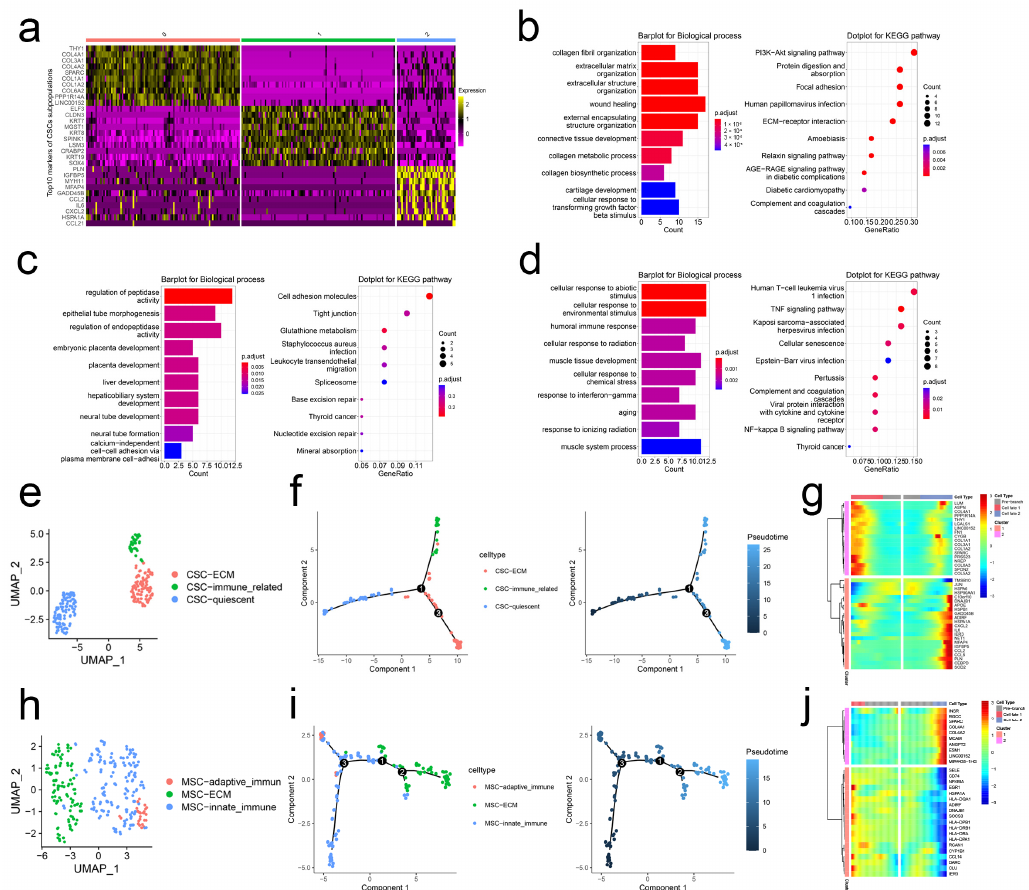
Figure 1. scRNA-seq analysis unravels the heterogeneity of CSCs and MSCs. ( a ) Top 10 markers of each subtype of CSCs. Top 10 terms of BP of GO and KEGG pathway enrichment analysis of Cluster 0 ( b ), 1 ( c ), and 2 ( d ). ( e ) Subpopulations of CSCs. ( f ) Pseudotime and developmental trajectory of the subpopulation of CSCs. ( g ) BEAM of MSCs. ( h ) Subpopulations of MSCs. ( i ) Pseudotime and developmental trajectory of the subpopulation of MSCs. ( j ) BEAM of MSCs.